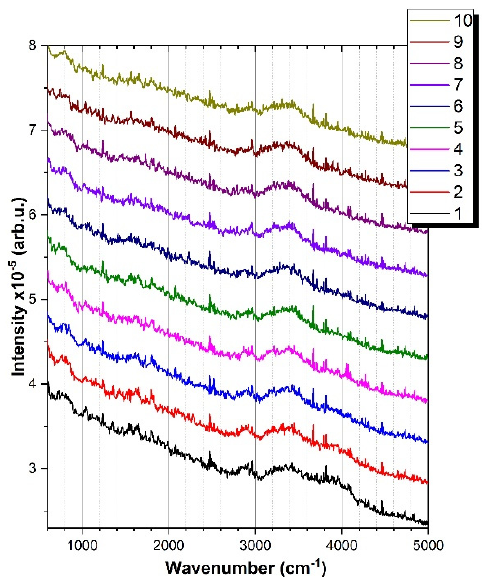
Figure 8. Raman spectra for an O / W emulsion (50% oily vitamin A ( v / v ) with the oil phase 2% vitamin A in sunflower oil and the water phase 10% STS in ultrapure water), recorded during 50 min of laser irradiation (each spectrum was averaged on 3000 laser pulses / 300 s).